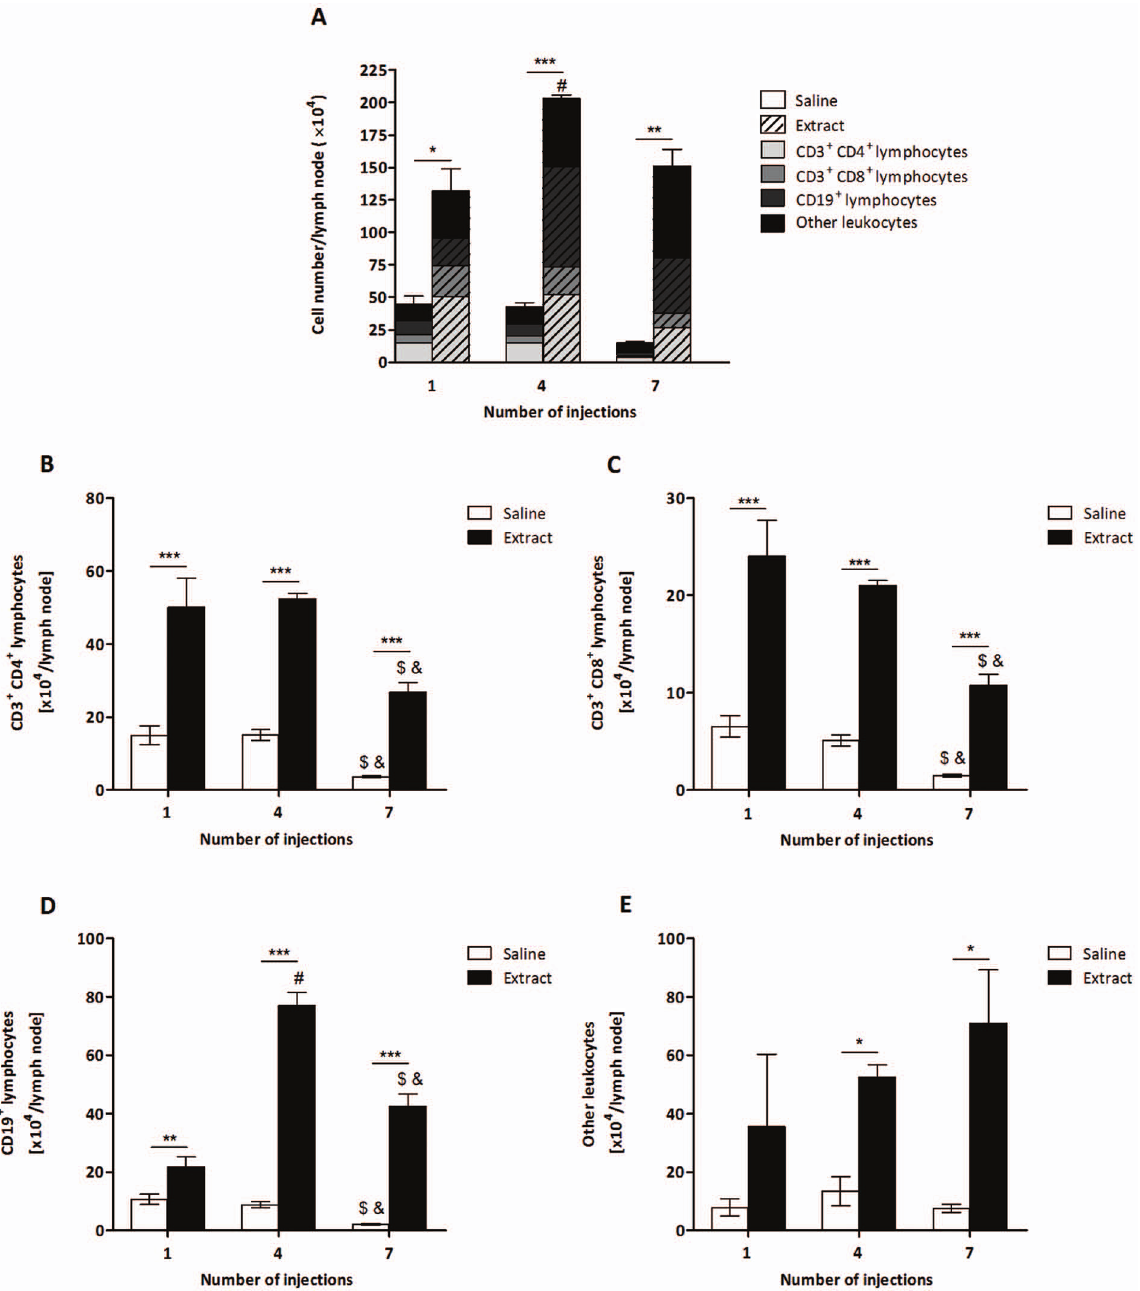
Figure 1. Determination of the total number of leukocytes from P . semirufa bristle extract-treated group. BALB/c mice were repeatedly injected with 50 m L of pyrogen-free saline with or without 10 m g (protein) of the extract in the footpad and, after the 1 st , 4 th and 7 th inoculations, the popliteal lymph nodes were collected and processed for flow cytometry analysis. (A) Total number of cells, (B) Total number of TCD4 lymphocytes, (C) Total number of TCD8 lymphocytes, (D) Total number of B lymphocytes and (E) Total number of other leukocytes. All graphs show mean values 6 SD. * p , 0.05, ** p , 0.01 and *** p , 0.001: significant differences between the mean values obtained with the saline group and the mean values of the P . semirufa group. The symbols indicate significant differences between the inoculations: 1 st 6 4 th ( # ), 1 st 6 7 th (&) and 4 th 6 7 th ( $